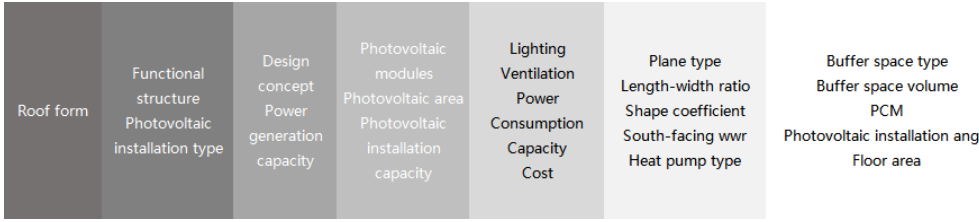
Figure 10. The priority of the zero-energy design strategy.